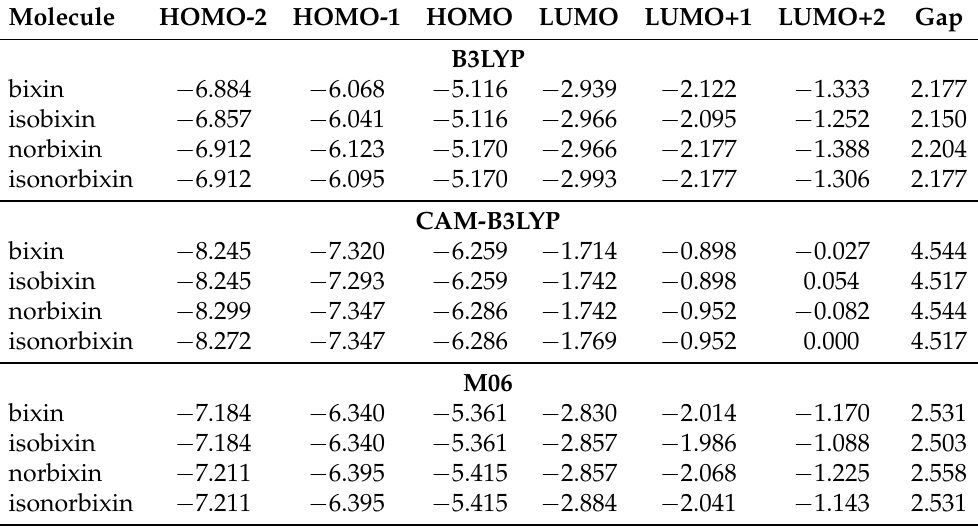
Table A7. Frontier MOs and gap energy values for the dyes in gas phase. These results were obtained by employing the 6-31G basis set. All values are in electron-Volt